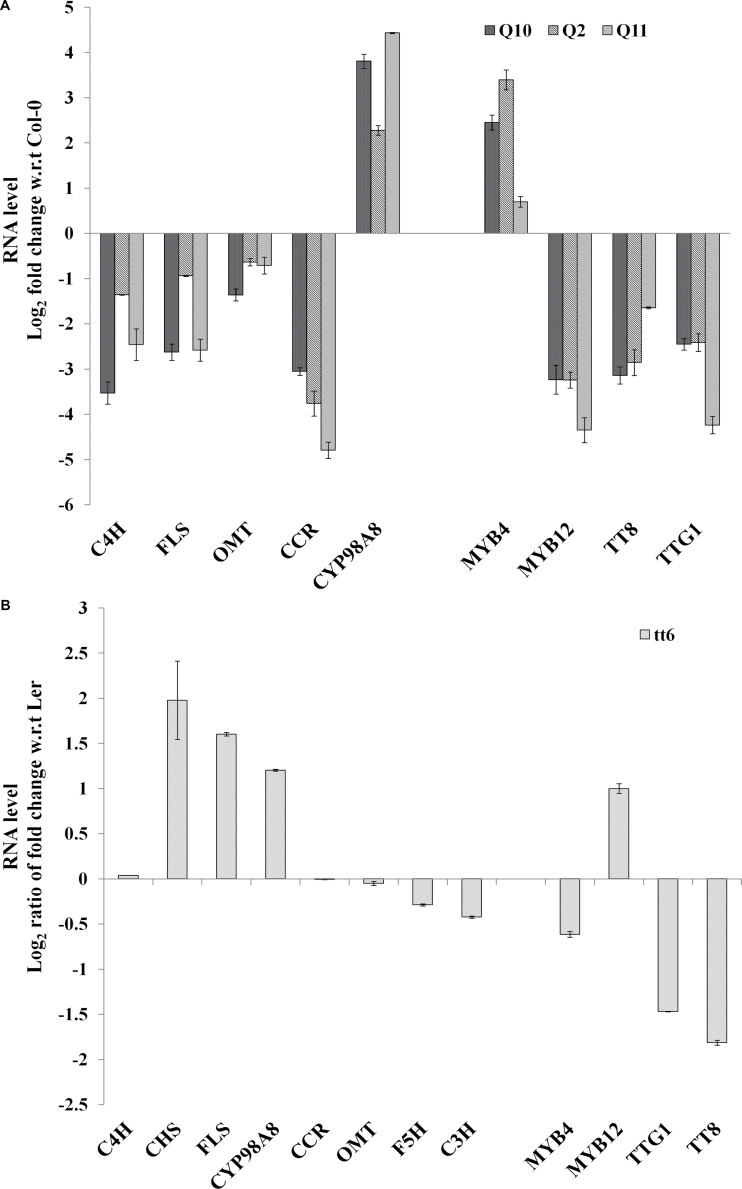
RNA levels of selected structural genes in 5-week-old QuoA transgenic lines and the tt6 mutant. (A) RNA levels of structural genes in QuoA transgenic plants. (B) RNA levels of structural genes in the tt6 mutant. Real-time quantitative PCR was performed and C
T values were normalized using tubulin as a control. Fold changes were calculated based on the ΔΔ C
T method. MYB4, MYB12, TTG1, and TT8 are regulators of phenylpropanoid pathway. C4H, cinnamate hydroxylase; FLS, flavonol synthase; CYP98A8, phenolamide pathway gene; CCR, cinnamoyl-CoA reductase; OMT, flavonol 3′-o-methyltransferase. Results are shown as means±SEM based on three replications (all significant at P<0.05) and experiments were repeated twice for all genes.